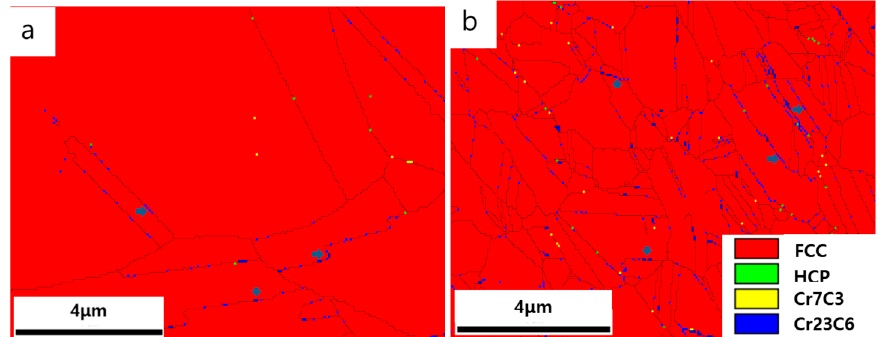
Figure 4. EBSD phase maps of annealed carbon-containing (NiCo) 75 Cr 17 Fe 8 C 0.34 ( a ) and (NiCo) 75 Cr 17 Fe 8 C 0.83 ( b ) alloys.